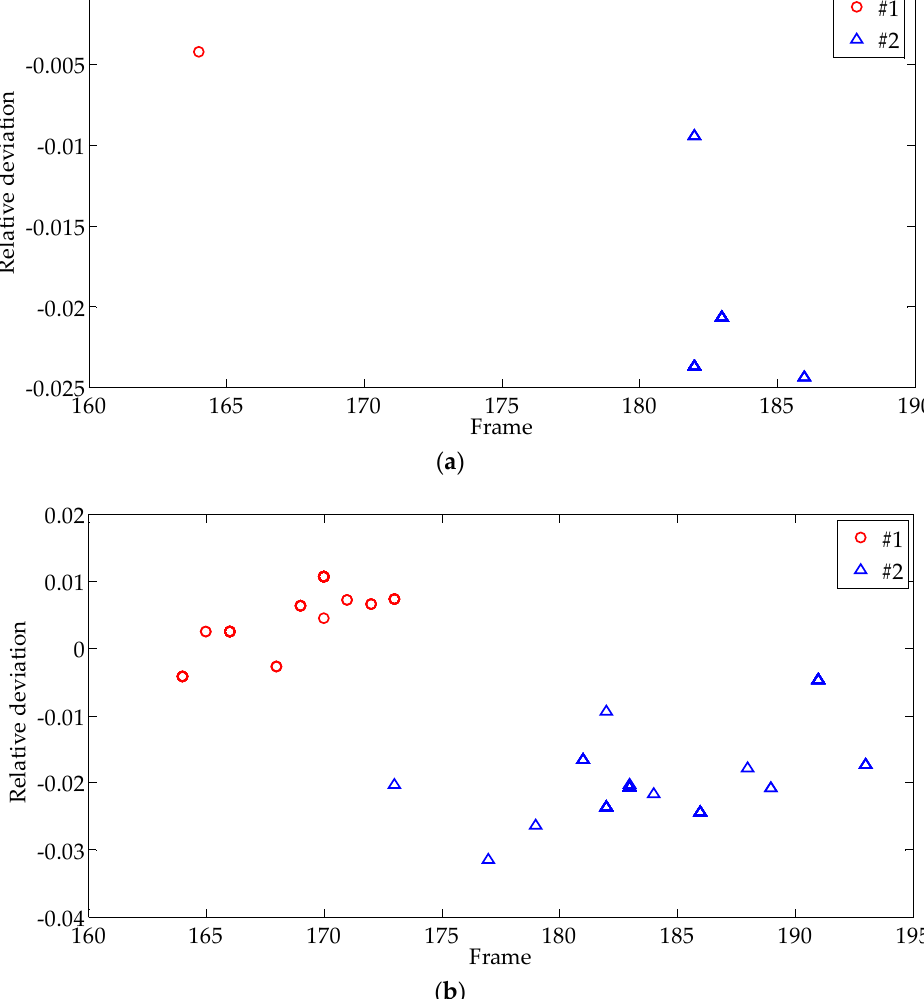
Figure 21. Discrete distribution of relative deviation of defect area: ( a ) Discrete distribution of relative deviation of defect area using uniform selection; ( b ) Discrete distribution of relative deviation of defect area using random selection.